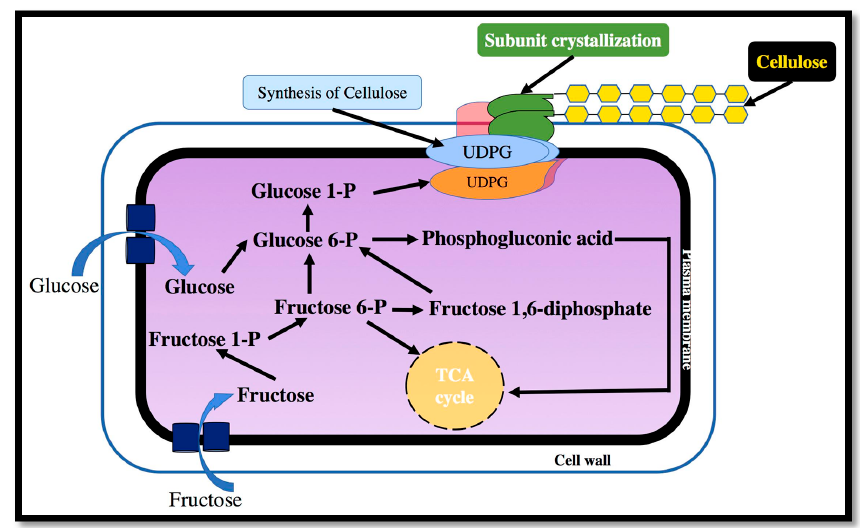
Figure 2. Biosynthetic pathway of cellulose in the cells of microorganisms.